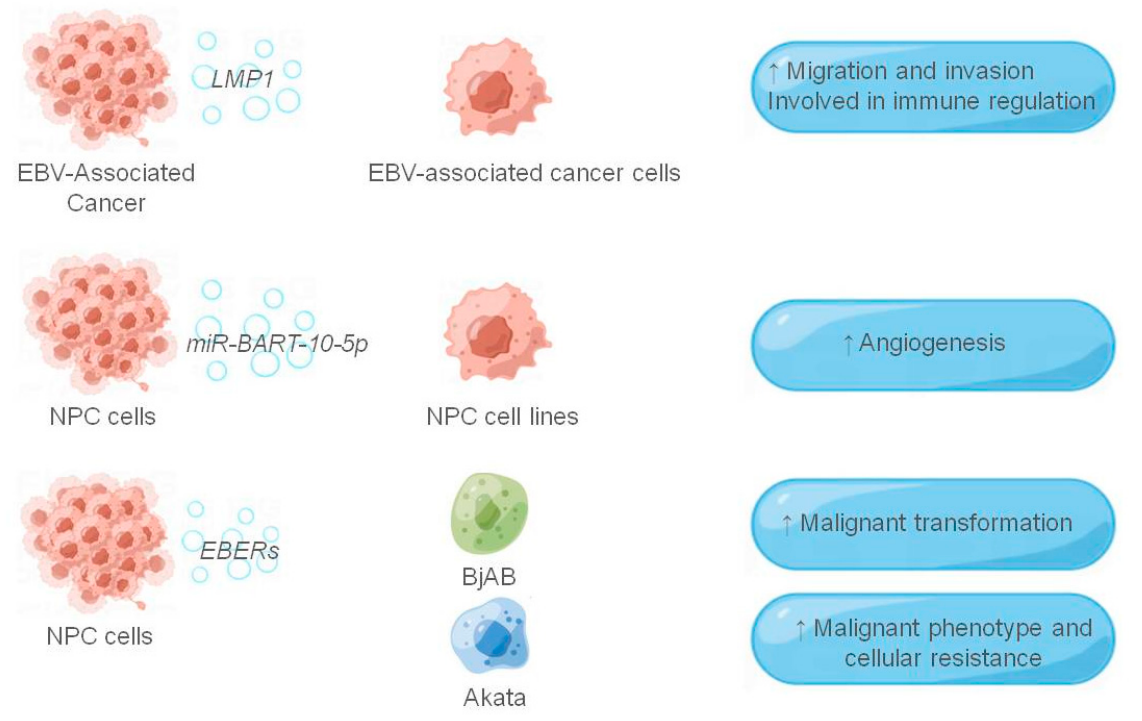
Figure 2. The role of exosomes in the EBV-associated tumor microenvironment. The figure shows the EBV-related components and their receptor cells that function in the exosomes, and the EBV-related components are shown in italics, and ↑ indicates that they play a role in promotion.